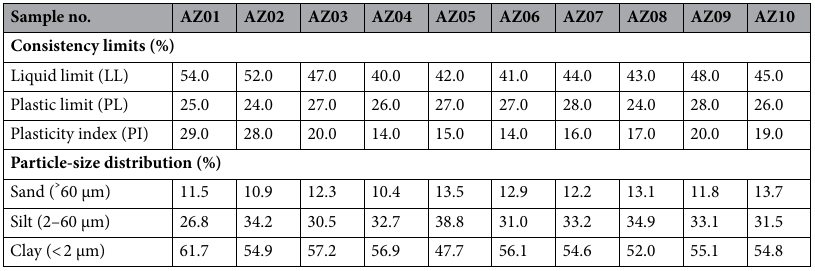
Table 4. The consistency limits (%) and Particle-size distribution of the studied clay samples.